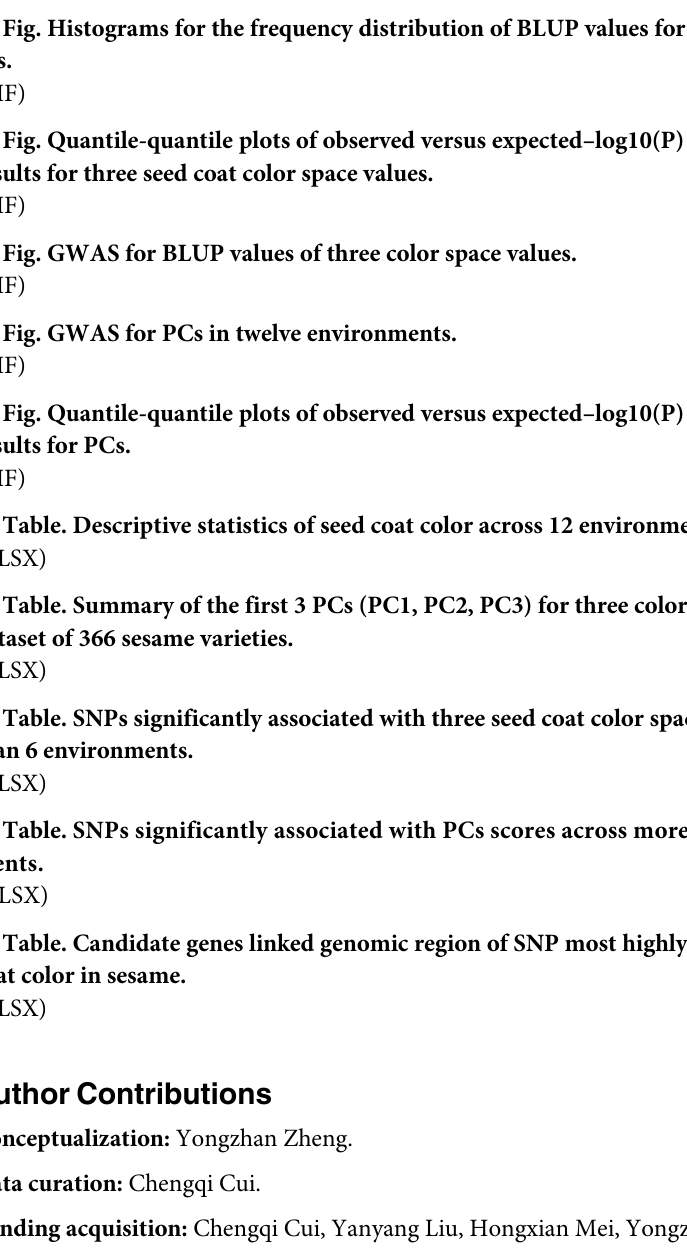
S1 Fig. Histograms for the frequency distribution of BLUP values for three color space val- ues. (TIF) S2 Fig. Quantile-quantile plots of observed versus expected–log10(P) values of GWAS results for three seed coat color space values. (TIF) S3 Fig. GWAS for BLUP values of three color space values. (TIF) S4 Fig. GWAS for PCs in twelve environments. S5 Fig. Quantile-quantile plots of observed versus expected–log10(P) values of GWAS results for PCs. S1 Table. Descriptive statistics of seed coat color across 12 environments. S2 Table. Summary of the first 3 PCs (PC1, PC2, PC3) for three color space values in the dataset of 366 sesame varieties. S3 Table. SNPs significantly associated with three seed coat color space values in more than 6 environments. S4 Table. SNPs significantly associated with PCs scores across more than 6 environ- ments. S5 Table. Candidate genes linked genomic region of SNP most highly associated with seed coat color in